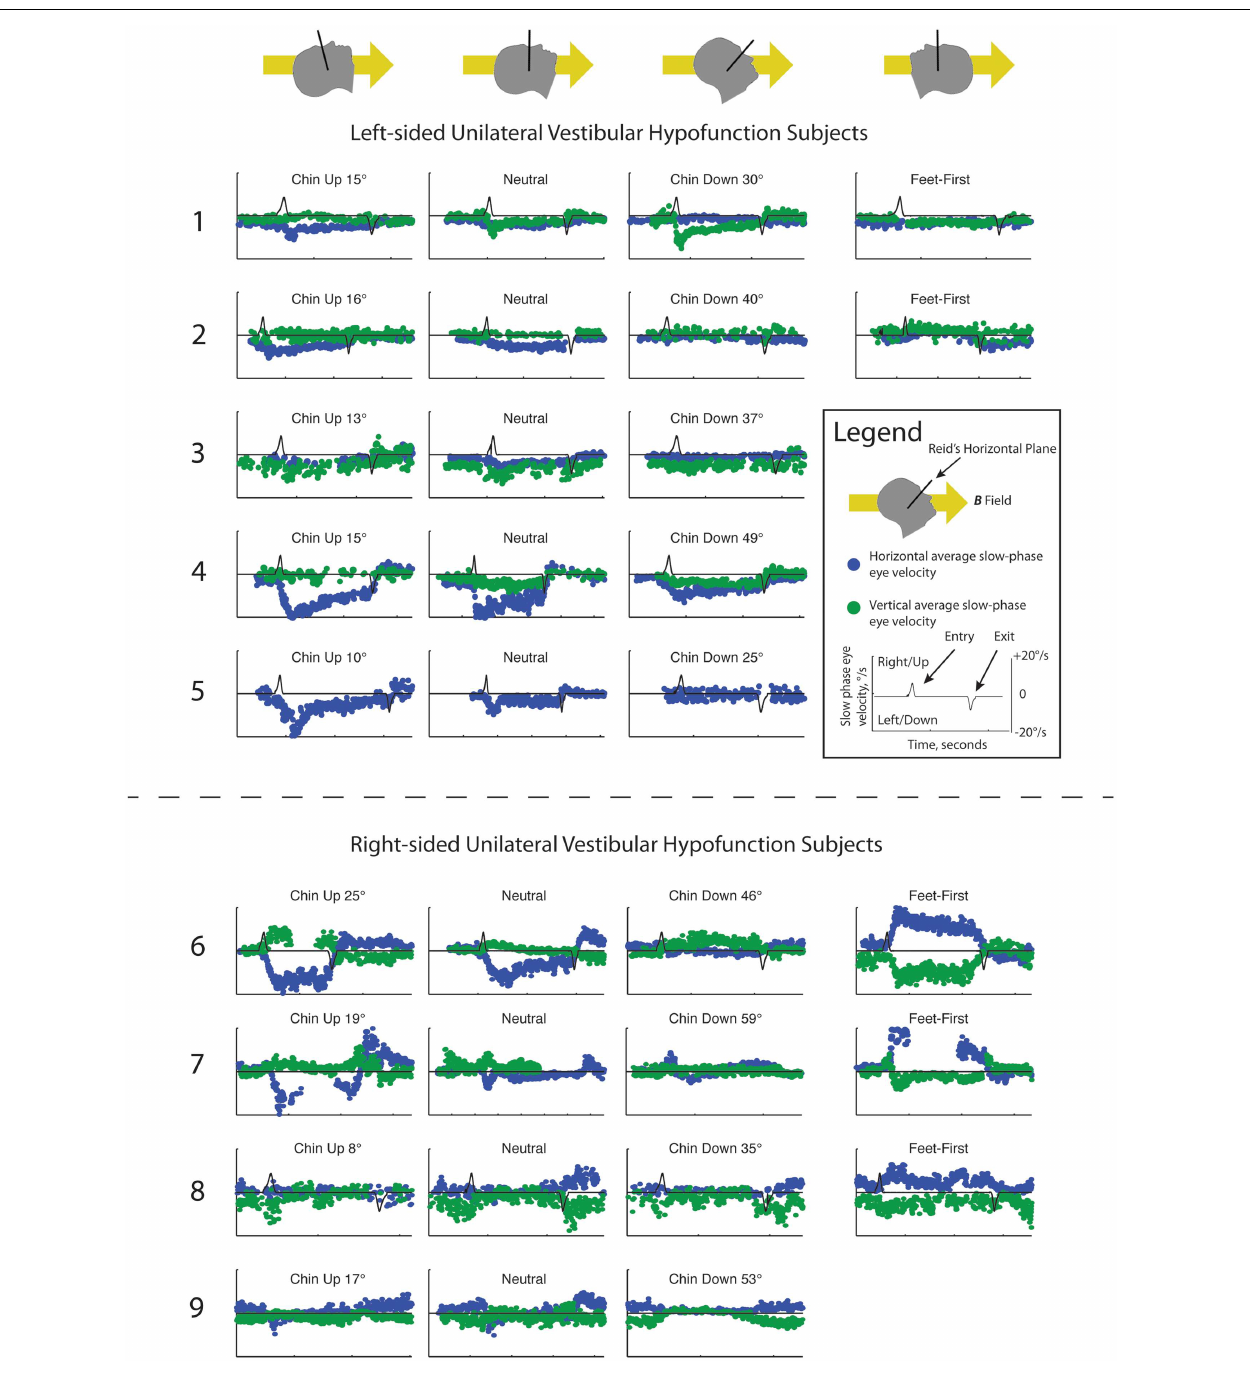
slow-phase velocity is shown with blue dots and vertical slow-phase velocity with green dots. Solid black line represents electromagnetic induction (d B /dt), measured using a wire coil. Electromagnetic induction peak and trough indicate, respectively, entry and exit from the bore of the